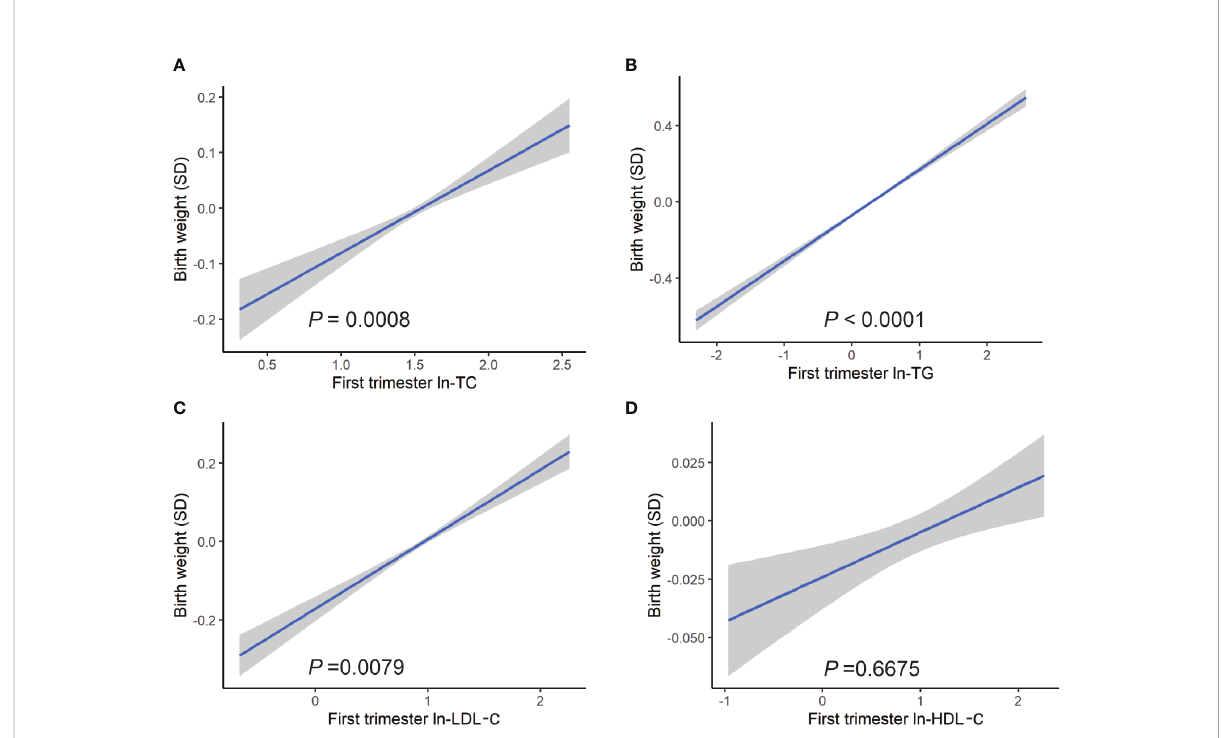
FIGURE 1 Association between ln transformed maternal lipid pro fi les in early pregnancy and birth weight. Linear regression models for (A) ln-TC, (B) ln- TG, (C) ln-LDL-c, (D) ln-HDL-c, and birth weight plotted as predicted mean with 95% CIs. Analyses were adjusted for maternal pre-pregnancy body mass index, age, mode of conception, parity, education, consumption of cigarettes, infant sex, gestational diabetes, and gestational hypertension